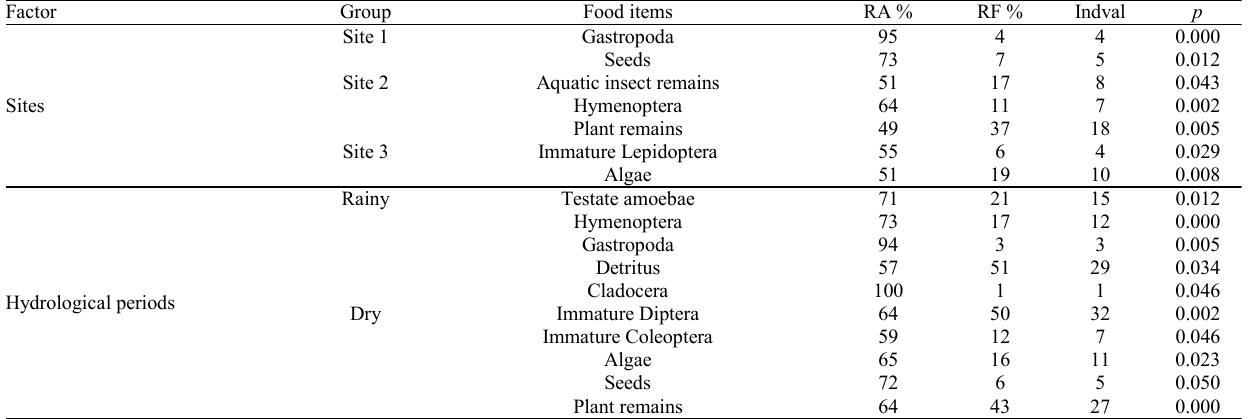
Table 4. Relative abundance (RA), relative frequency (RF) and Indicator value (Indval) of food items consumed by the fish community, discriminated among sites and hydrological period in Itiz stream, Ivaí River basin, Paraná State, Brazil. Only items with signicant values, p < 0.05, Monte Carlo permutation test are listed.